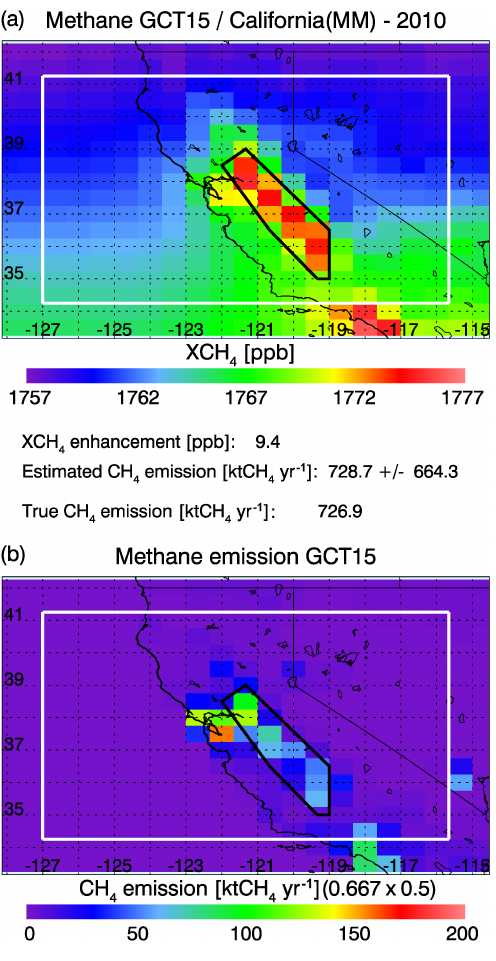
Figure 9. (a) GCT15 X CH 4 over parts of California. The white rectangle denotes the “surrounding region” of the “source region”, which is surrounded by a polygon shown as thick black line. The source region covers the area between the two cities Modesto and Merced in central California. The text below (a) lists the X CH 4 enhancement, (cid:49)X CH 4 (9.4ppb), and the estimated emission (729 ± 664ktCH 4 yr − 1 ). The “true” emission of the source region has been computed from the GCT15 emissions (bottom panel) and is 727ktCH 4 yr − 1